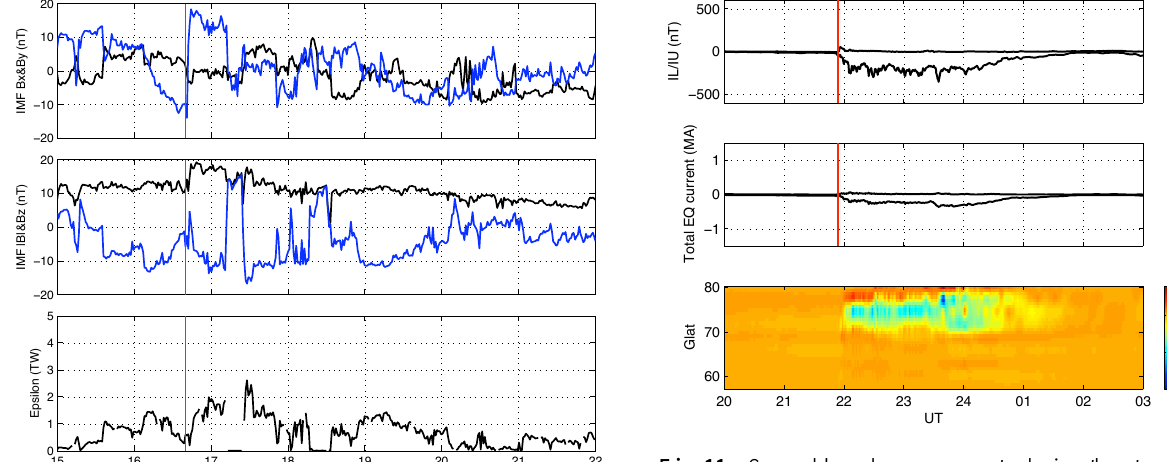
Fig. 11. Ground-based measurements during the storm recovery phase substorm (substorm 3) as a function of Universal Time. Pan- els from top to bottom: (1) auroral electrojet index (upper and lower) calculated from the IMAGE network, (2) strength of the total electrojet currents (eastward positive, westward negative) estimated from the magnetometer data, and (3) electrojet current density de- duced from magnetometer recordings by 1-D upward continuation method (green/blue colours for westward and yellow/red colours for